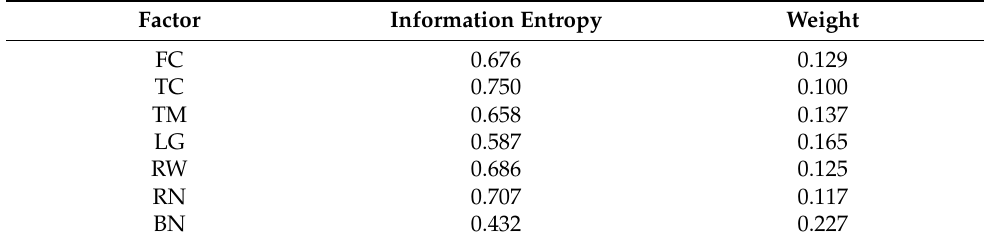
Table 3. Information entropy and